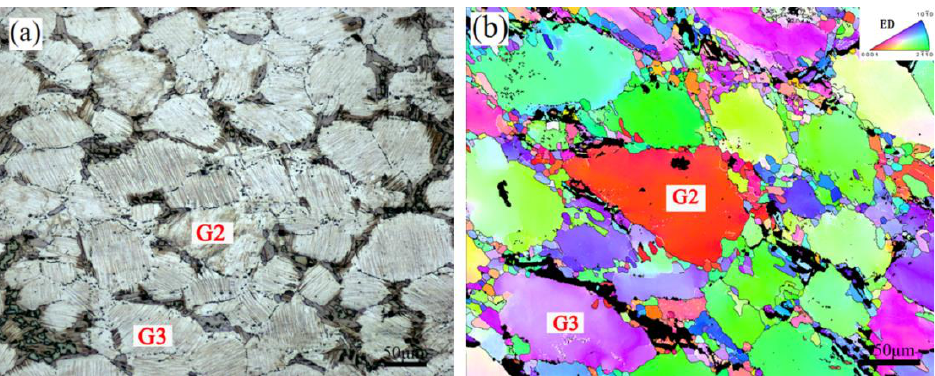
Figure 9. The ( a ) OM image and ( b ) IPF map of the grain with low content LPSO phases (G2) and high content LPSO phases (G3).